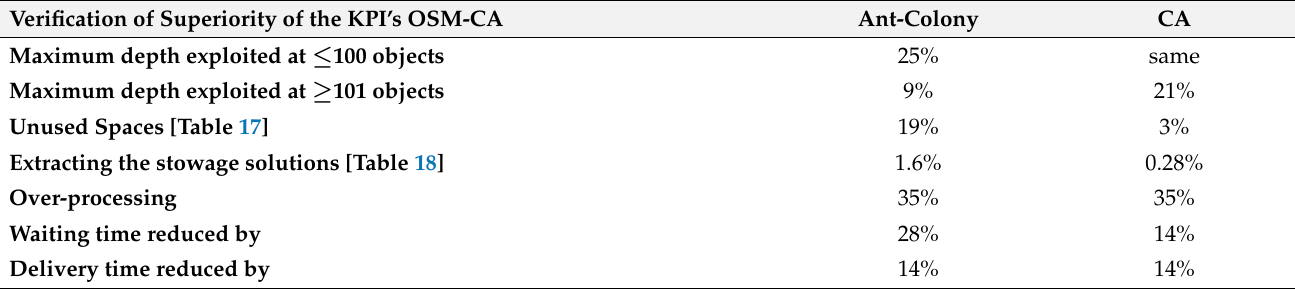
Table 20. The KPI of superior the proposed algorithm OSM-CA-IoT, according to the e-commerce objectives for more than 120 randomly